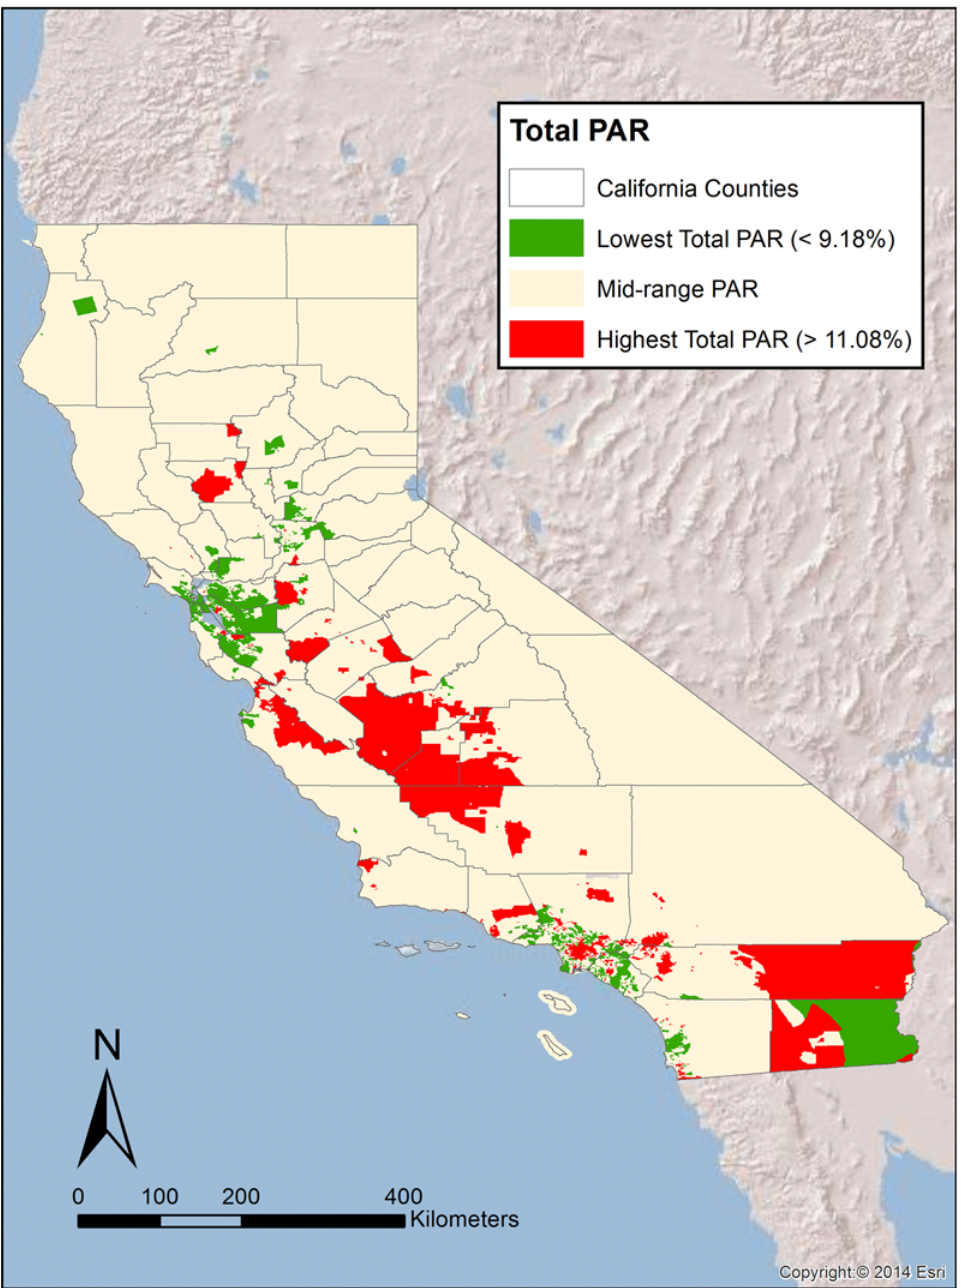
Fig 1. Geographic distribution of low and high PAR Census tracts across California. Census tracts in the green and red are those in the lowest and highest quintiles for Total PAR, respectively.